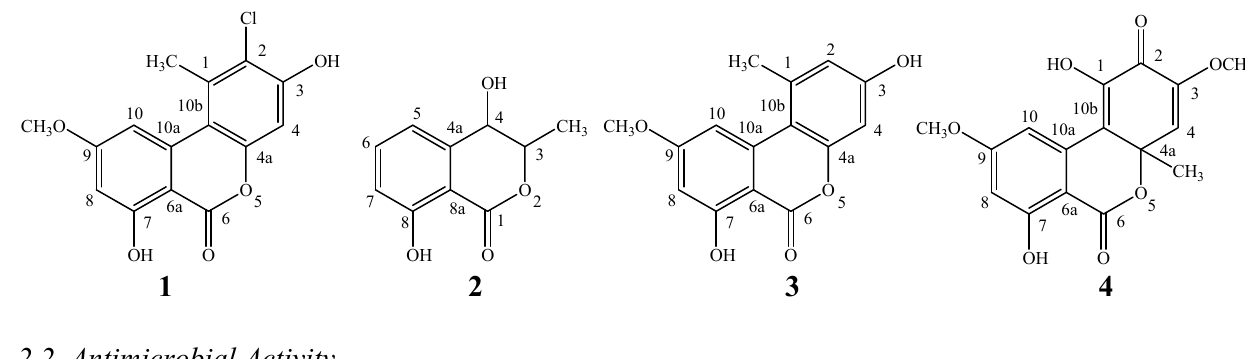
Figure 1. Chemical structures of the benzopyranones 1 – 4 .